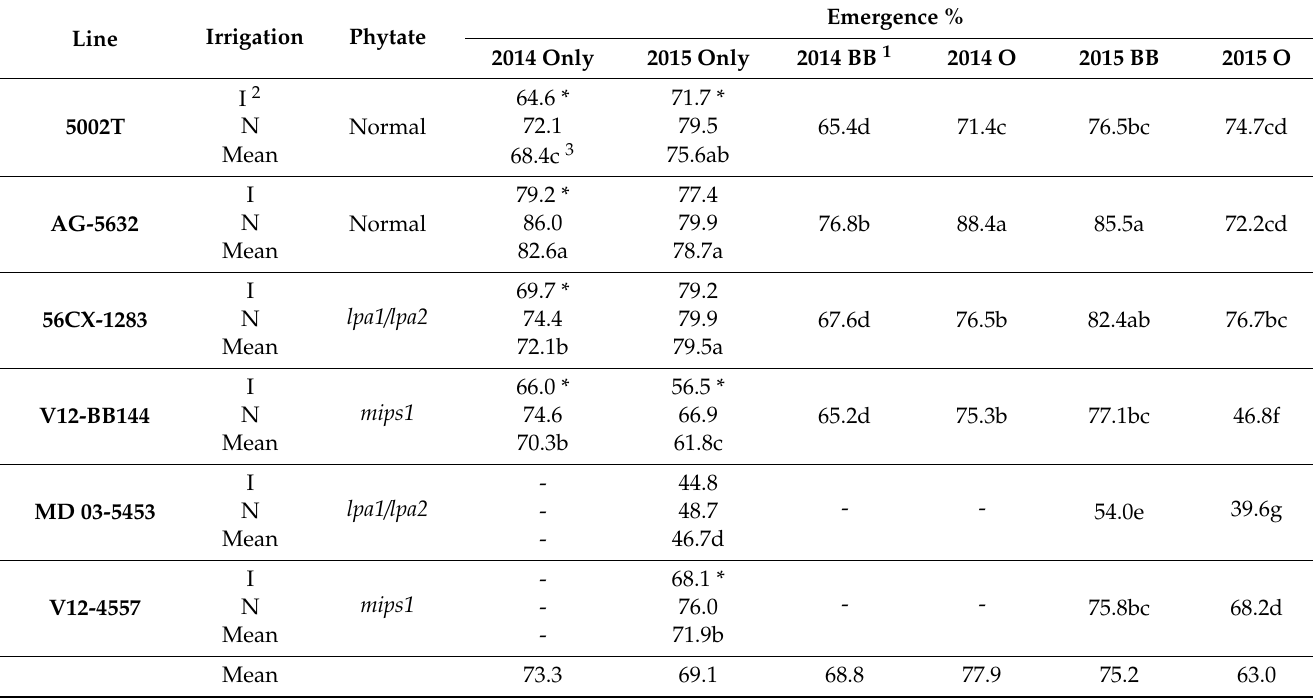
Table 3. Field emergence of two normal-PA (NPA) and four LPA soybean varieties grown at Blacksburg and Orange in 2014 and